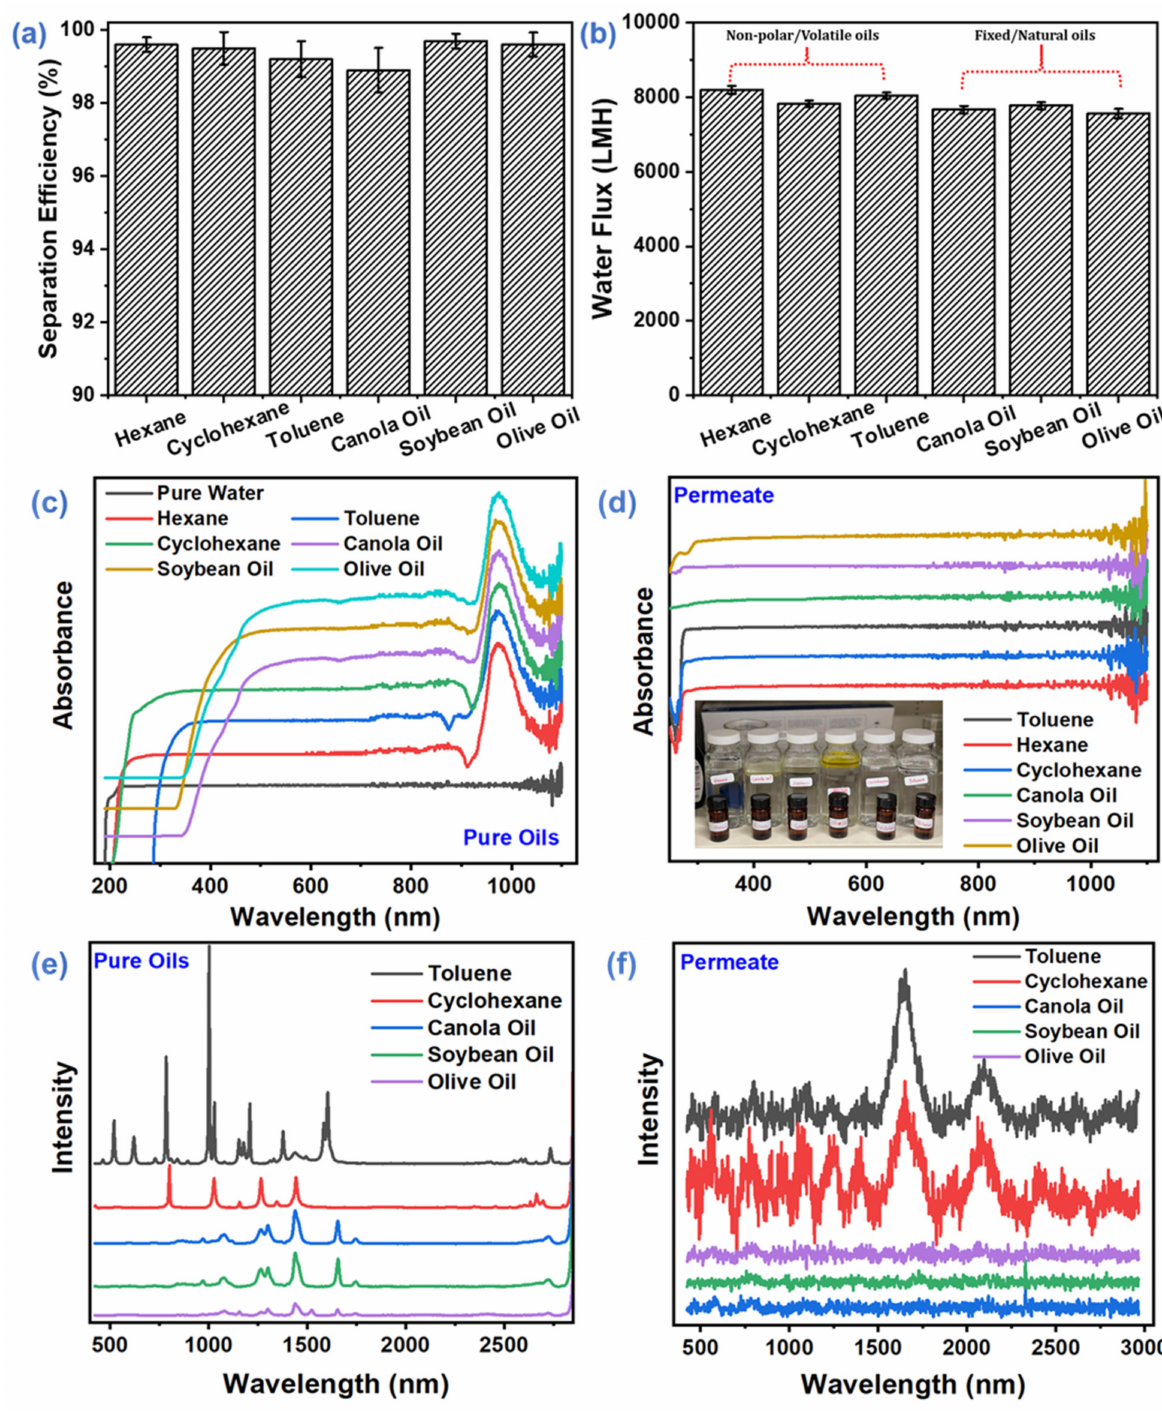
Figure 8. Separation performance of the optimized 27EVOH_22% ENMs for different oil–water mixtures: ( a ) Separation efficiency, ( b ) Water flux and UV–visible spectra of pure oils and permeate, ( c ) Pure oils, ( d ) Permeates. Raman spectroscopy spectra for pure oils and permeates, ( e ) Pure oils, and ( f ) Permeates to confirm separation efficiency